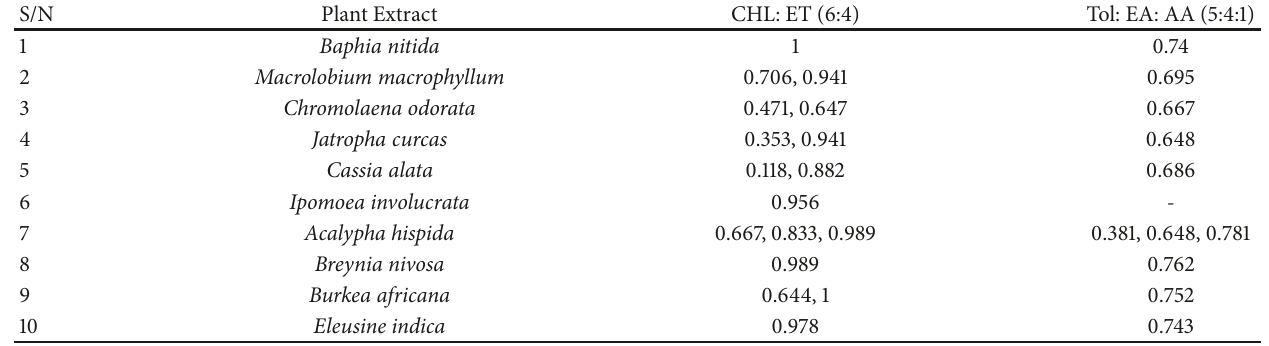
Table 3: Thin layer chromatography retention factor using mobile phase CHL: ET (mobile phase I) and Tol : EA : AA (mobile phase II).